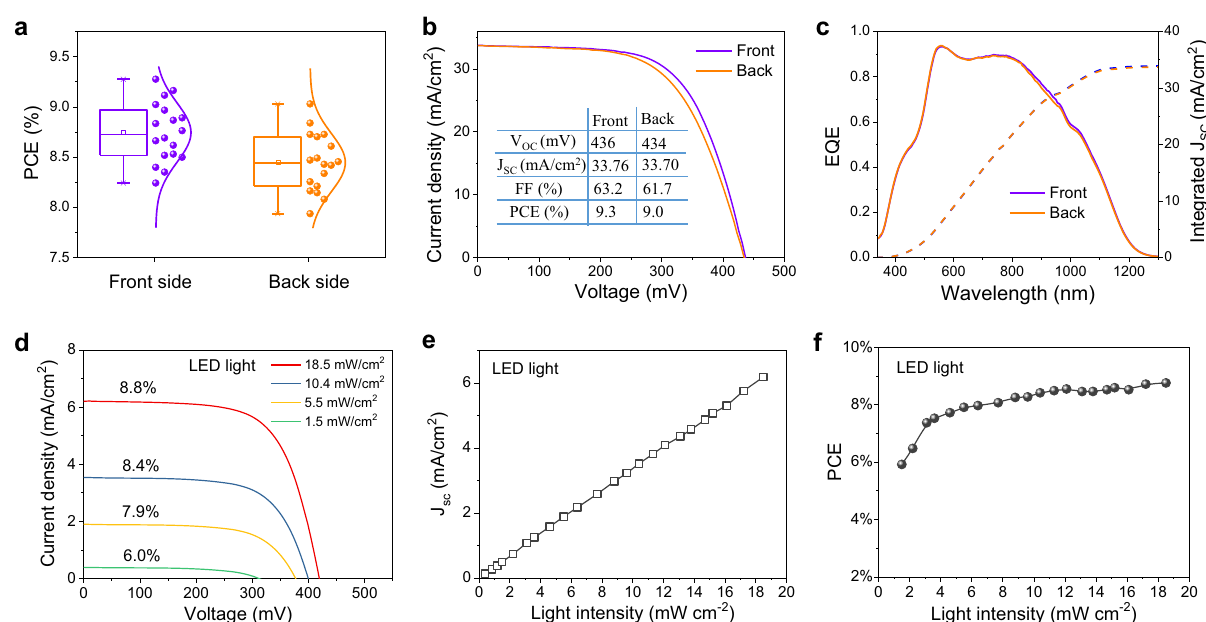
Fig. 4 Photovoltaic device properties of bifacial fl exible CZTSSe solar cells. a Statistical PCE distribution boxplots of front and back sides on bifacial fl exible CZTSSe solar cells. b The J – V curves and c EQE spectra of champion double-sided cells. d The J – V curves of front solar cell under the LED light illuminations with different intensities. e The J SC evolution with LED light intensity. f The PCE evolution with LED light intensity is less than 4 mW/cm 2 , the fi ll factors show obvious normalized PCE degradation of the device evolved with bending decrease. From the ef fi ciency trend in Fig. 4f, the PCEs of fl exible numbers (0 – 4000 times) at a fi xed angle of 50° are shown in Fig. 5d. The bifacial solar cells can keep more than 95% of ori- ginal ef fi ciencies after bending 3000 times. Before and after bending treatments, the J – V curves are almost coincident for the two sides, con fi rming high fl exibility of the obtained solar cells (Supplementary Fig. 5). With increasing bending times, the degradation with 15% after 4000 times is from the front device, in which the crystalline CZTSSe fi lms is gradually destroyed by stretching stress (Supplementary Fig. 4a). From the above, the fl exible CZTSSe solar cells under stretching stress can stand larger-angle (>60°) bending but not endure numerous bending times (0-3000 times). On the other hand, the device under squashing stress can stand numerous bending times (>4000 times) but not endure larger-angle bending (0 – 60°). It is an